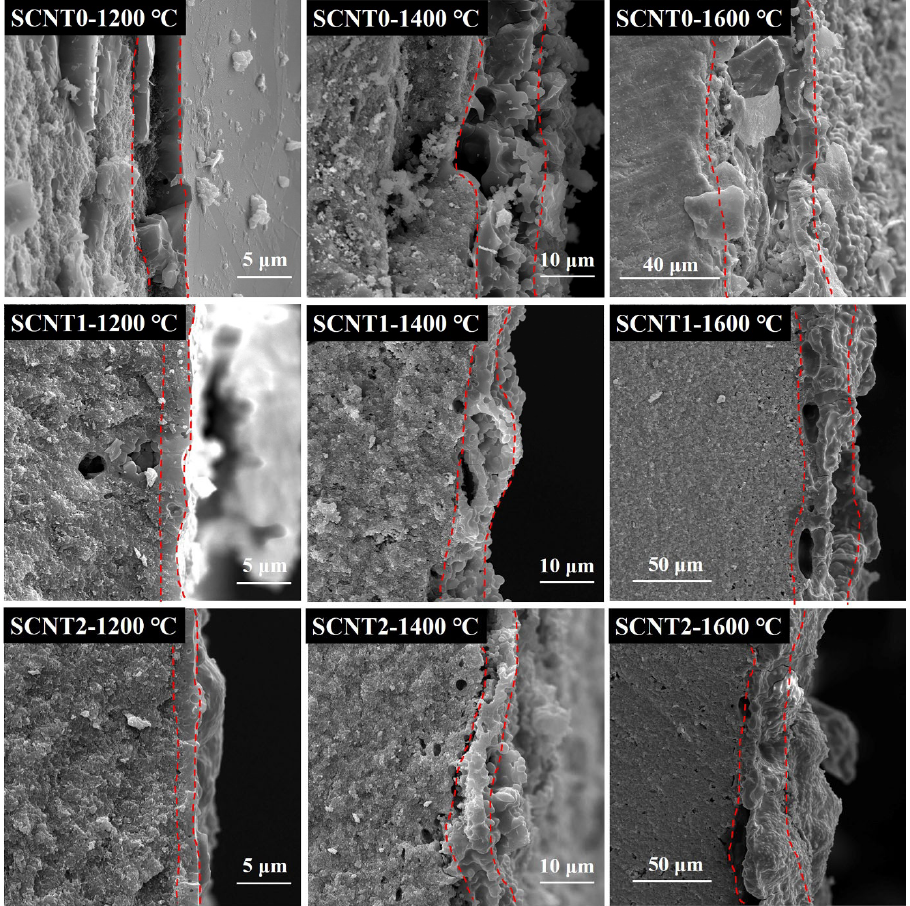
Fig. 10 Oxidation layer thickness of Si 2 BC 3 N ceramics after oxidation